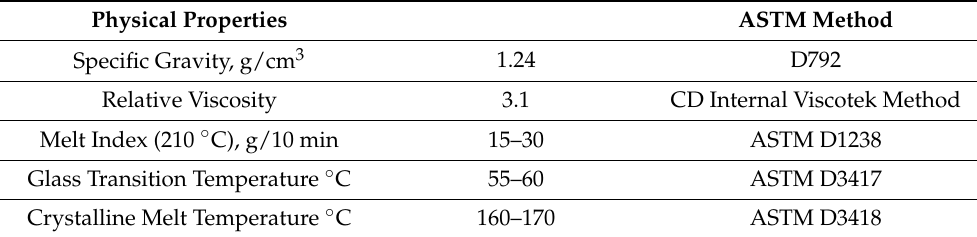
Table 1. Physical properties of 6201D poly(D, L-lactide) (manufacturer’s